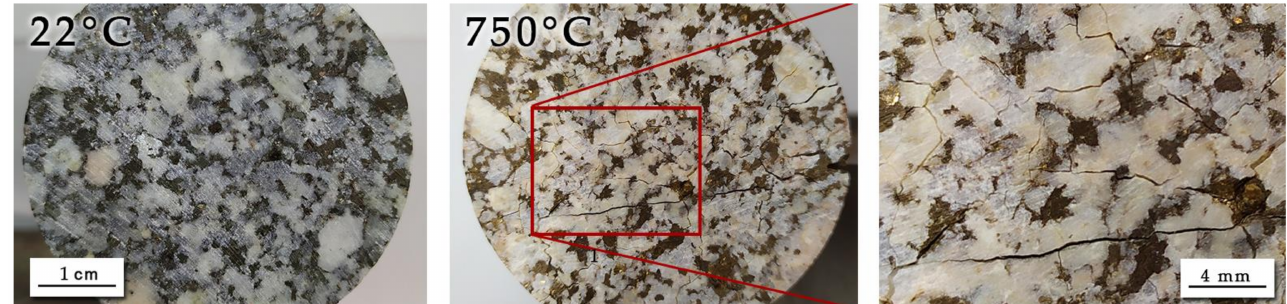
Figure 8. Overview images of a (22 ◦ C) room temperature ( left ) and a heat-treated (750 ◦ C) sample ( middle ). Examine the crack development on the magnified surface of the 750 ◦ C heat-treated specimen ( right ).